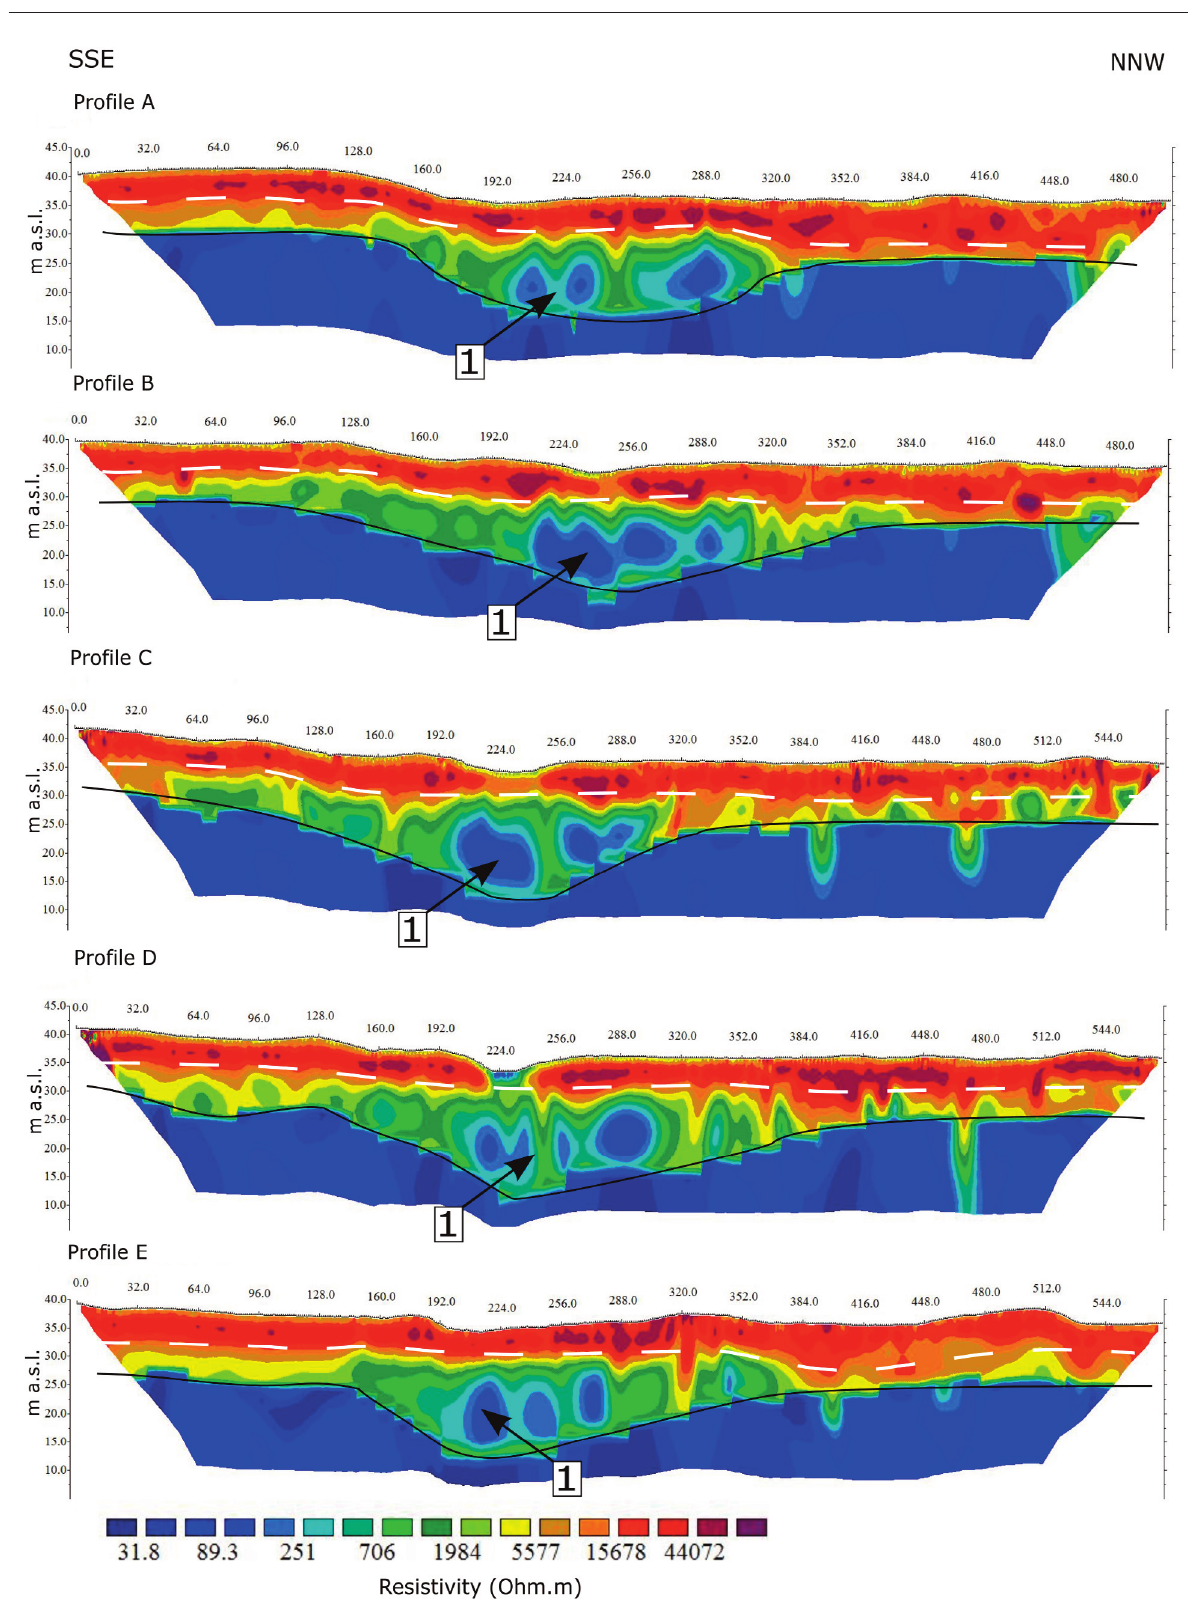
Fig. 4. Electrical resistivity tomography results. 1, a zone of low resistivity. The groundwater level is shown by the white dashed line. The black line represents the top of the low-resistivity layer. For the location of the profiles, see Fig.